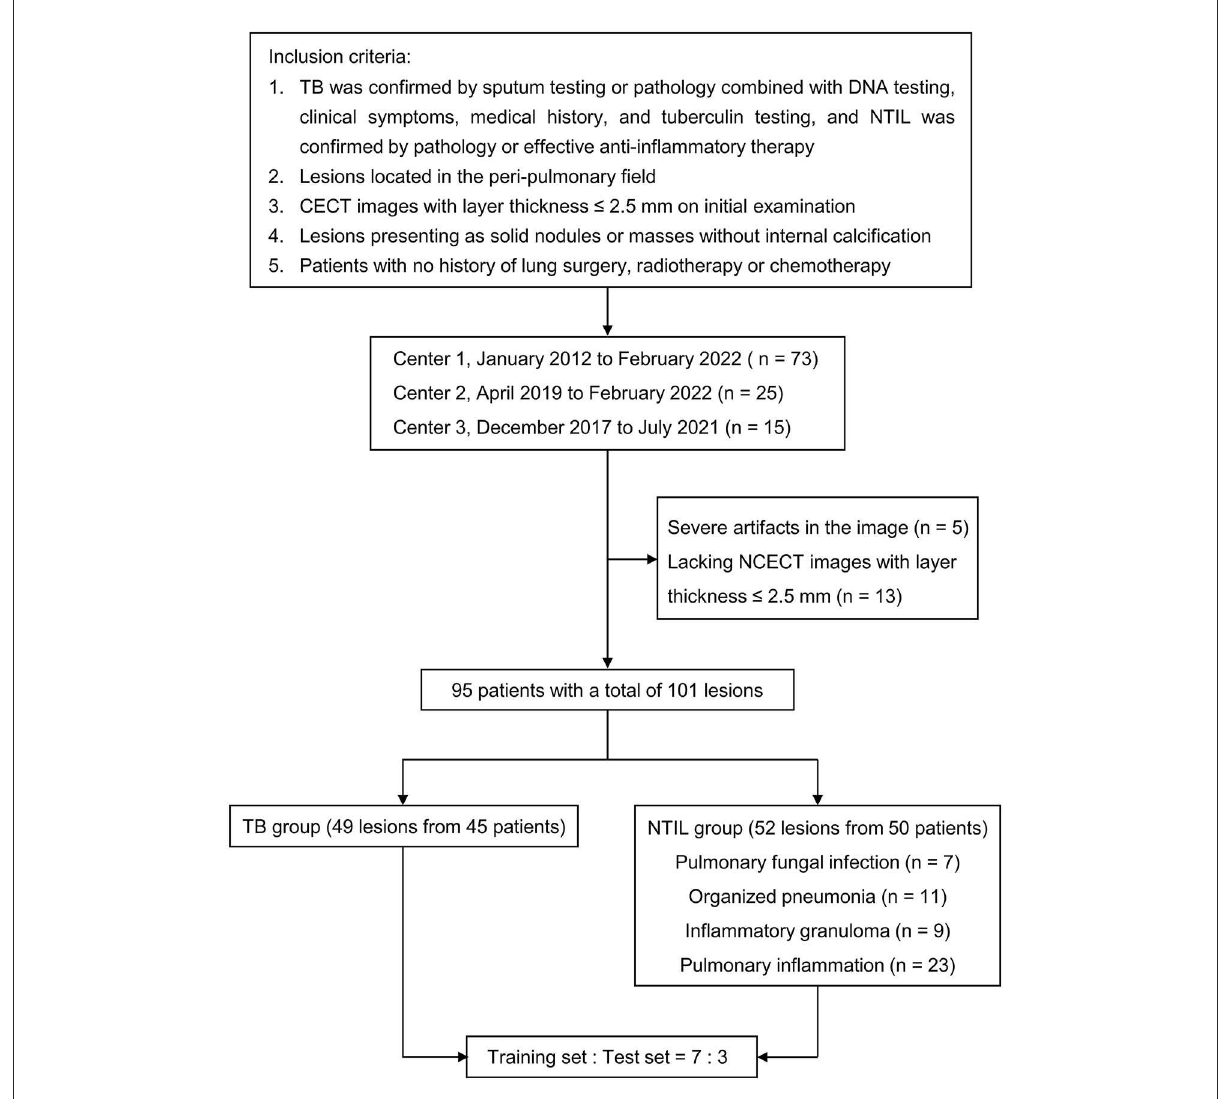
FIGURE1 Flowchart of study population. TB, tuberculosis; NTIL, non-tuberculous infectious lesions; NCECT, non-contrast enhanced CT; CECT, contrast-enhanced